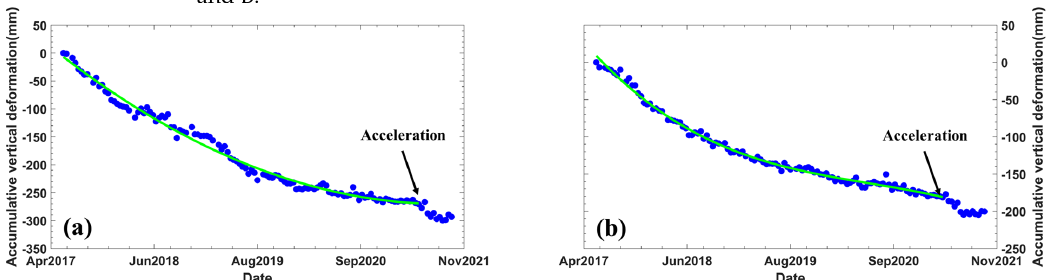
Figure 15. Deformation time series in the vertical direction at two points P5 ( a ) and P6 ( b ) of Xiamen Xiang’an Airport, whose positions are marked in Figure 6. Figure 14. Deformation time series in the vertical direction at four points P1 to P4 ( a – d ) of regions A and B.